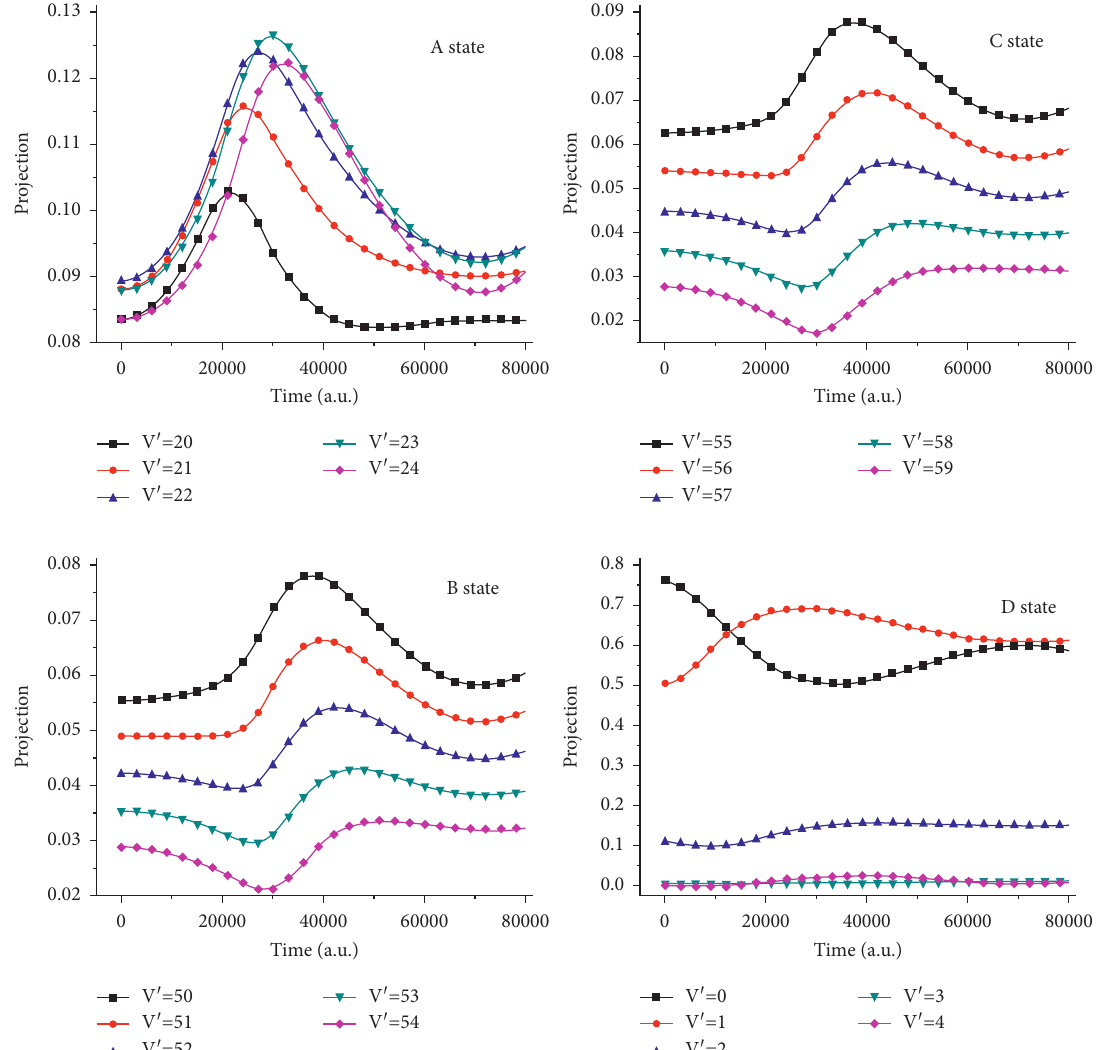
Figure 5: The projections of the time-dependent vibrational wave function of Yb 2 , interacting with a resonant laser pulse, on the main five vibrational eigenstates of excited states ( A 1 Σ u+ , B 1 Π u , C 1 Σ u+ , and D 1 Π u ), corresponding to laser pulse parameters: amplitude ε 0 � 0.169; duration t f 41341.37; frequency ω matches transition energy (in atomic